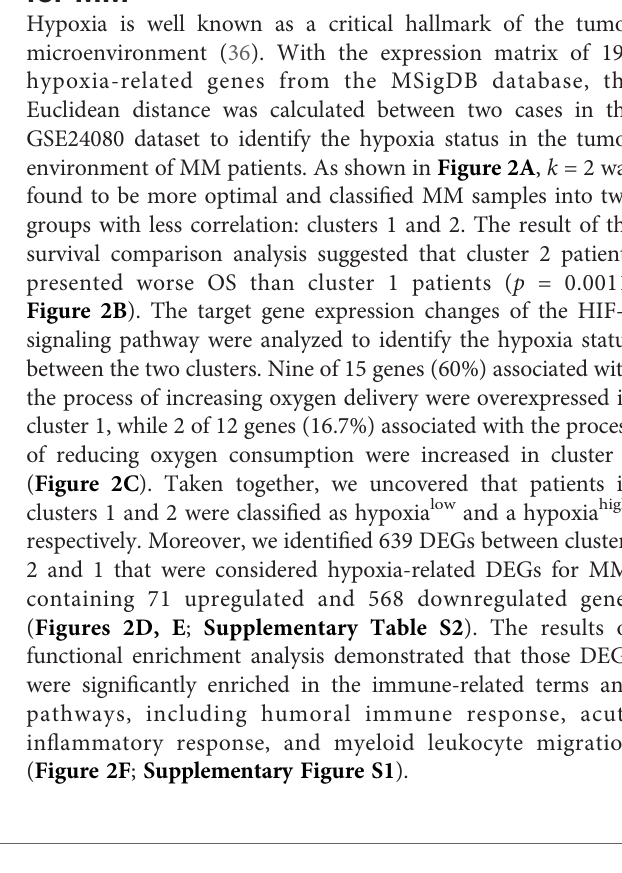
TABLE 1 | Characteristics of gene-speci fi c real-time PCR assays. Gene/Accession No. Mer Amplicon (bp) Conc.